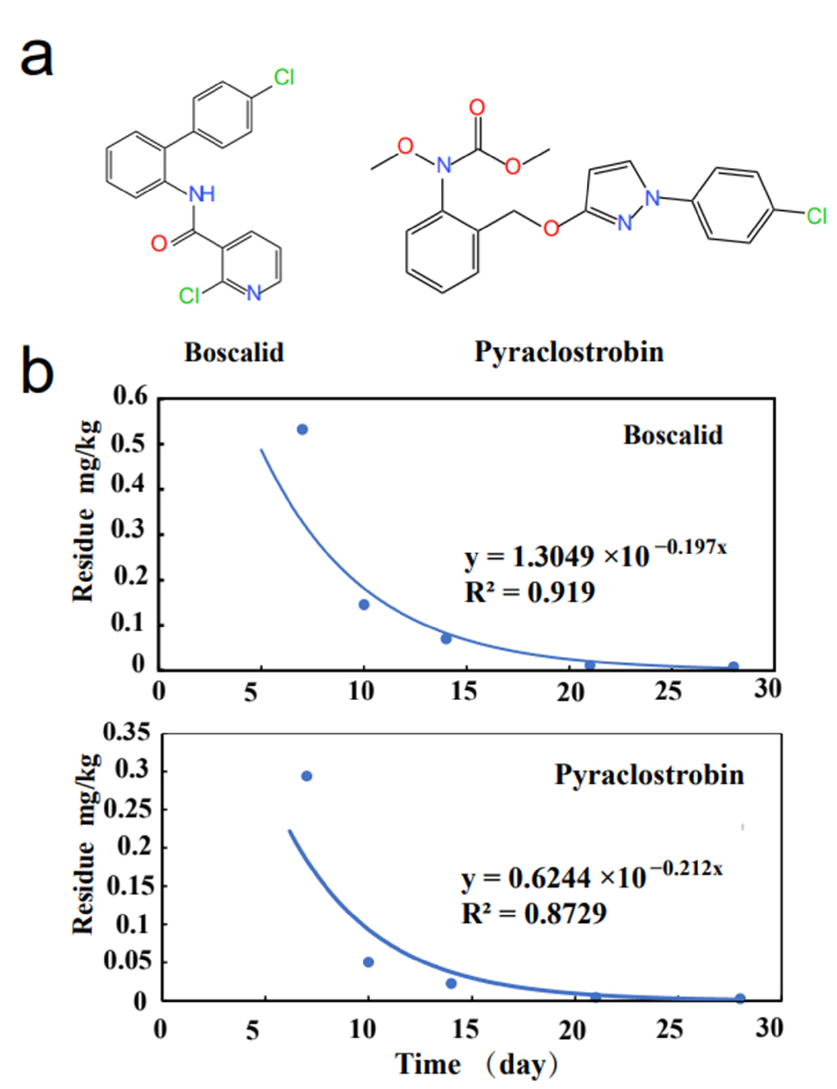
Figure 1. ( a ) Chemical structures and ( b ) half-lives of boscalid and pyraclostrobin in watermelon in Yueyang city of Hunan province.